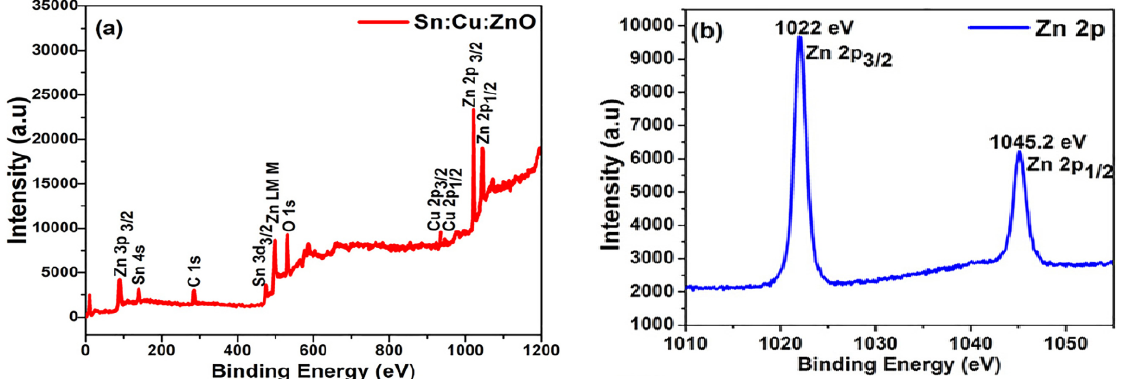
Figure 8. XPS data of the Sn:Cu/ZnO nanomaterial